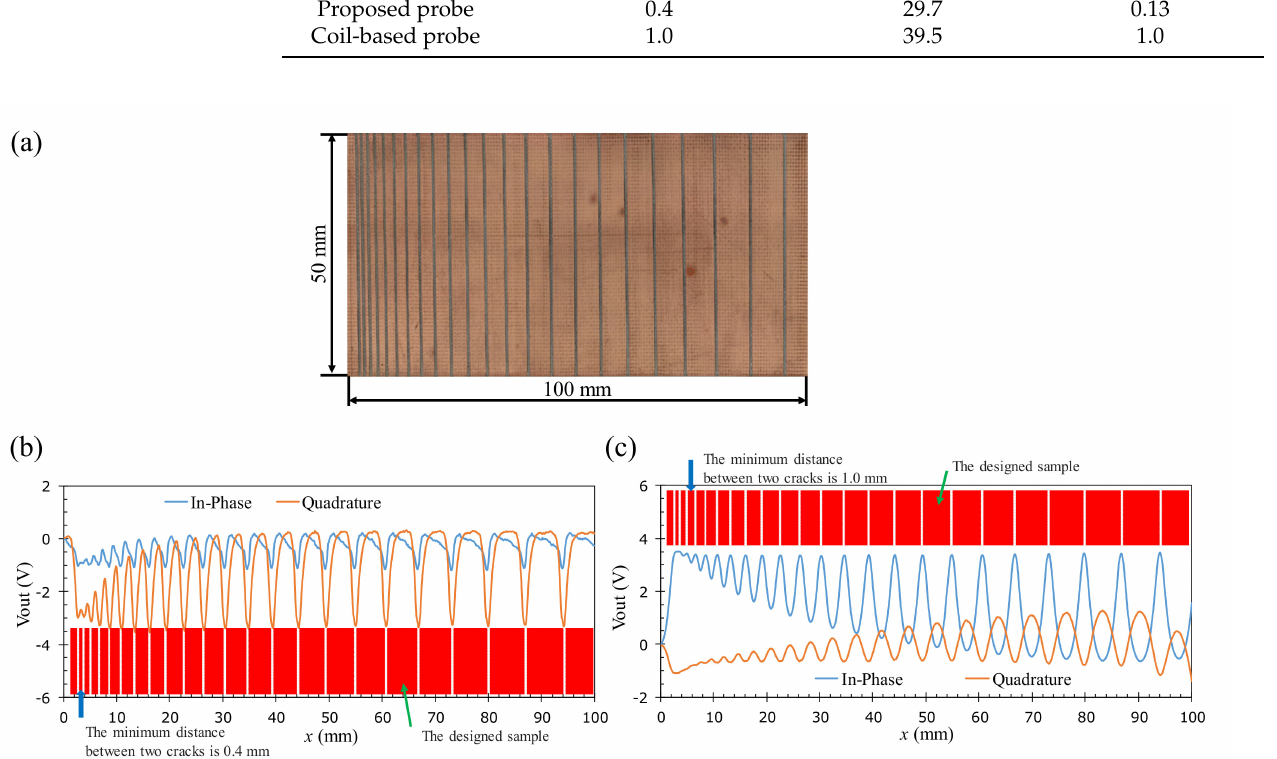
Figure 25. Determining the spatial resolution of the probe. ( a ) The photograph of the sample with the 23 artificial cracks with the increasing distance between cracks of a 0.3 mm arithmetic progression, ( b ) the 1D scanning result of the proposed probe, and ( c ) the 1D scanning result of the coil-based